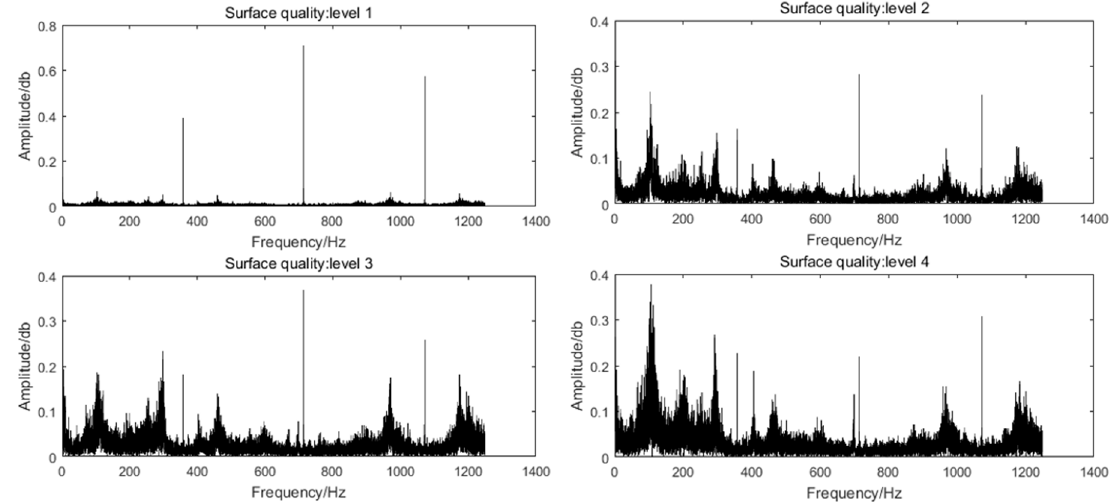
Figure 6. FFT of bending moment signals of different surface quality levels.